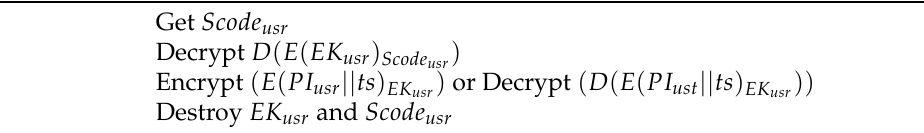
Table 2. Storage procedure of personal information on IoT